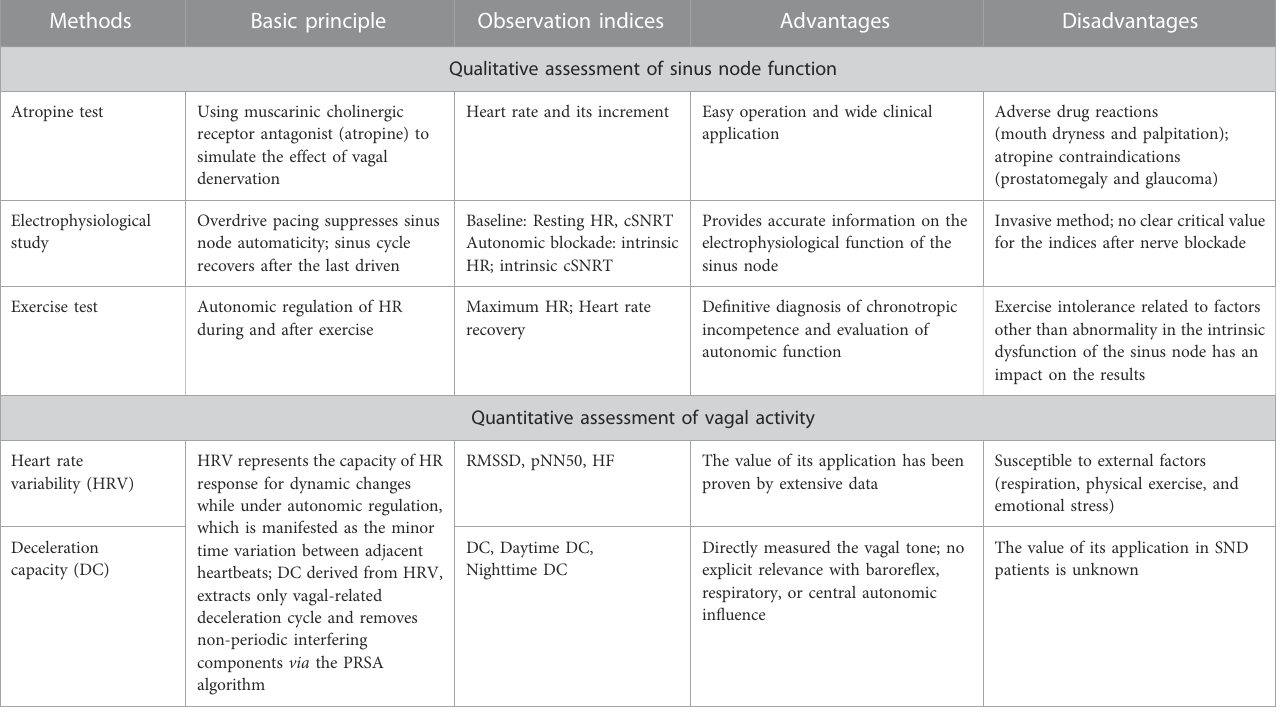
TABLE 3 Comparison of assessment methods for sinus node function and vagal